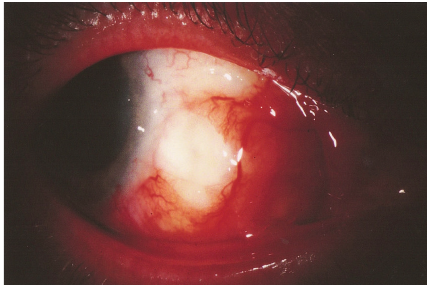
Figure 1: Slit lamp photograph showing area of redness and abscess formation on the temporal aspect of the globe.